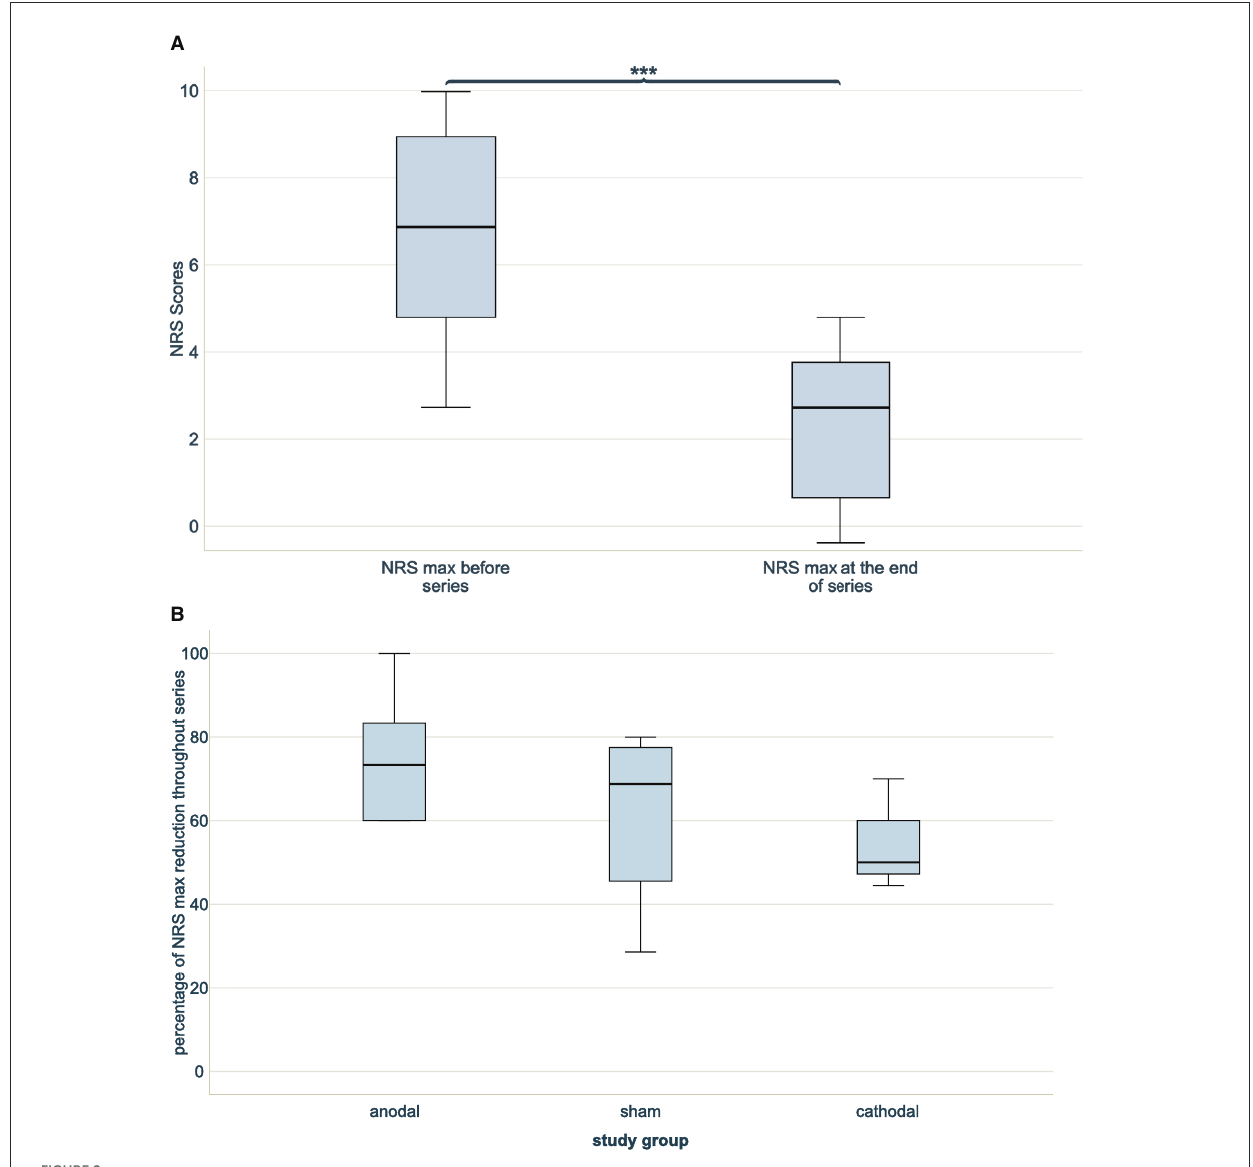
FIGURE2 NRS scores through series without dropouts. (A) Two boxplots indicating NRS max at beginning and at the end of combined infiltration and stimulation series. A significant NRS reduction was achieved ( *** p < 0.001), n = 13. (B) Three boxplots showing the percentages of reduction of NRS score at the end of infiltration and stimulation series compared to the beginning between blind groups (anodal n = 6, sham n = 4, cathodal n = 3). No difference in reduction was noted ( n = 13, p =